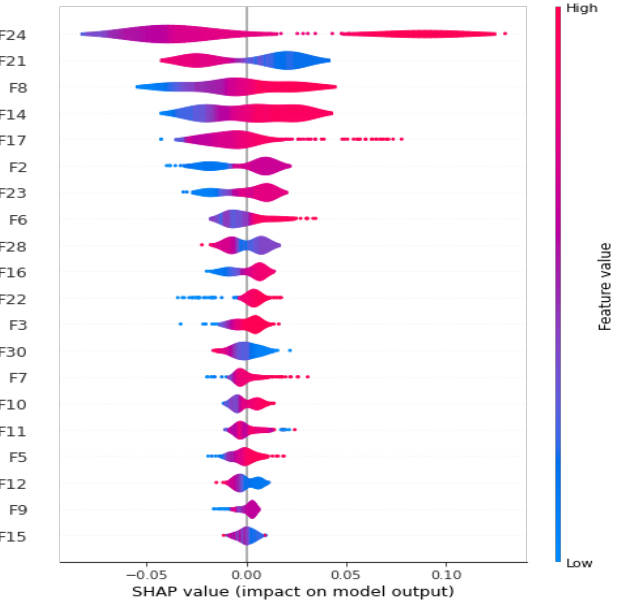
Figure 11. Combined effect of features on model output.